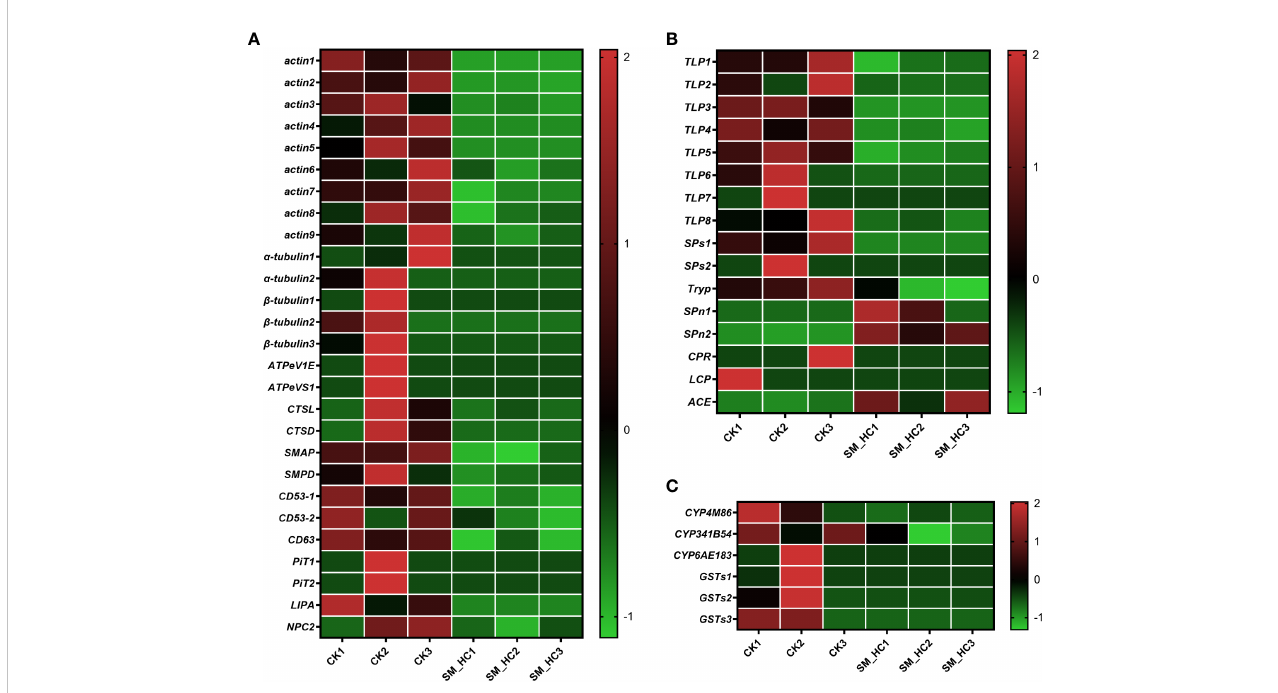
FIGURE 8 Heatmap analysis of downregulation immune-related genes in H cunea infected by SM1. The control groups were labeled as CK1, CK2 and CK3. H cunea groups infected with SM1 were labeled as SM_HC1, SM_HC2 and SM_HC3. (A) Cellular immune. (B) Melanization. (C) Detoxi fi cation